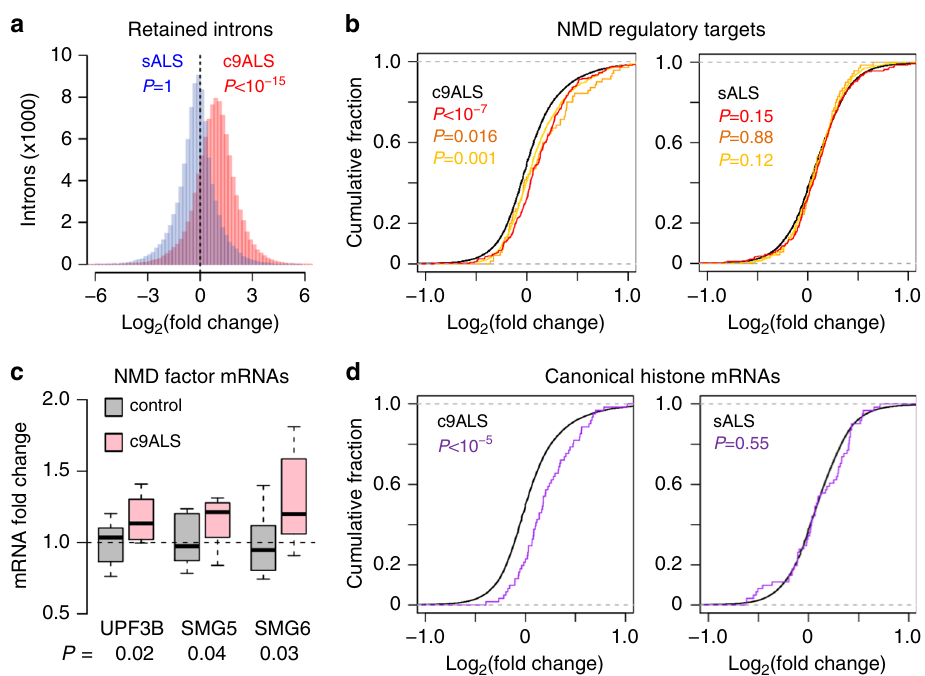
Fig. 1 NMD targets and canonical histone mRNAs accumulate in c9ALS brains. a Histograms showing changes in intron read densities between c9ALS and controls (red), or between sALS and controls (blue). P values, one-sided Mann – Whitney U tests. b Cumulative distribution functions (CDFs) of changes in RNA abundance for all genes (black), NMD targets identi fi ed in Johnson et al. ( N = 275, red), Tani et al. ( N = 76, orange), and in Colombo et al. ( N = 1271, yellow), comparing between c9ALS and controls (left) or sALS and controls (right). P values, two-sided Mann – Whitney U tests. c Changes in mRNA abundance of known NMD factors between c9ALS and controls. Expression levels were normalized to the means of control subjects. Boxes indicate the medians and interquartile ranges (IQRs). Whiskers represent 1.5x IQR. P values, two-sided unpaired t tests. d CDFs of changes in RNA abundance for all genes (black) and canonical histone genes ( N = 87, red and blue), comparing between c9ALS and controls (left) or sALS and controls (right). P values, two-sided Mann – Whitney U